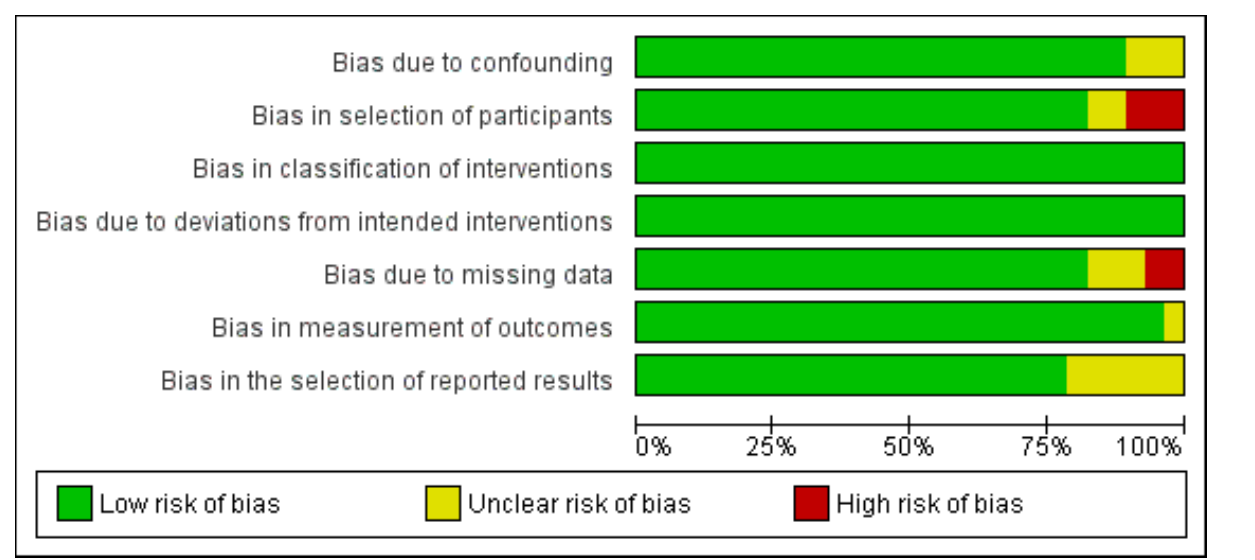
Figure 2. Risk of bias assessment of selected studies. Articles selected for inclusion were level 4 studies based on the Oxford Level of Evidence and were published between 2009 and 2022 (Table